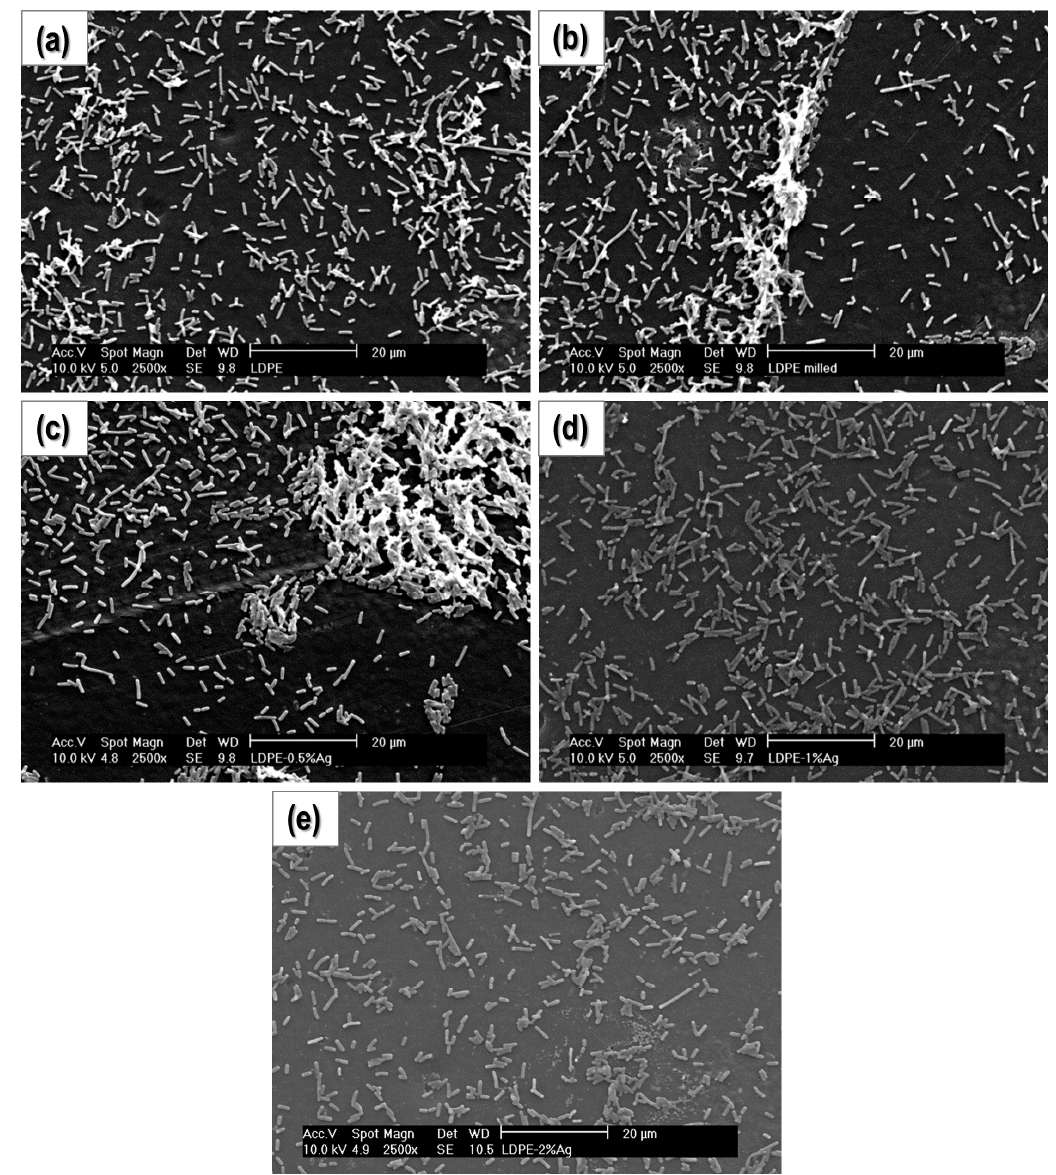
Figure 6. SEM micrographs obtained at 2500× for: ( a ) PE-Ground; ( b ) PE-Milled; ( c ) PE-0.5% Ag; ( d ) PE-1% Ag and ( e ) PE-2% Ag.